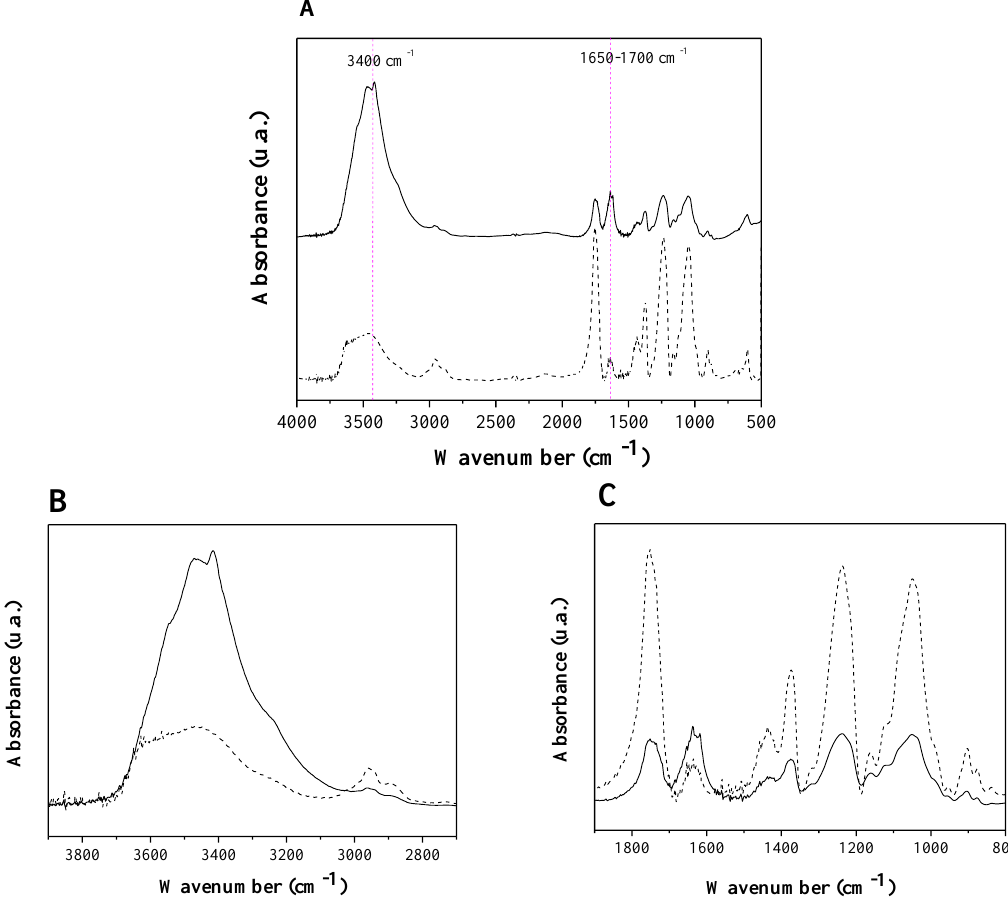
Figure 5. Spectrum in the infrared region for CTA (dashed line) and CTA-LU (straight line) ( A ) complete spectrum; ( B , C ) cutting of the most important regions of the spectrum.